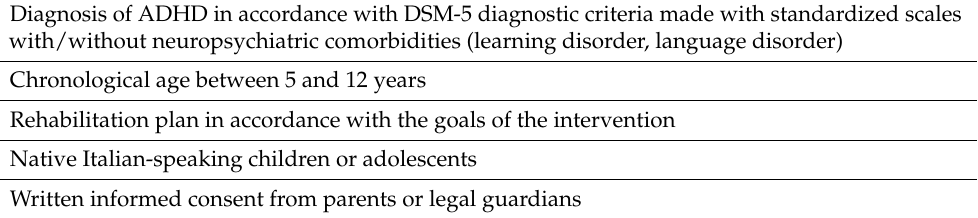
Table 1. Eligibility criteria used at recruitment